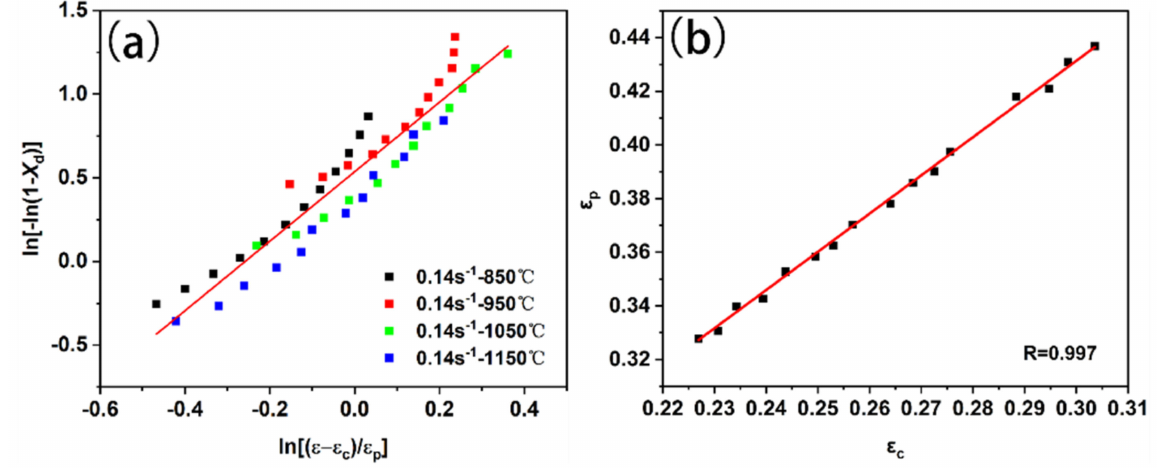
Figure 7. Relationship between: ( a ) ln [( ε − ε c )] − ln[( − ln(1 − X d ))], and ( b ) σ c − σ p